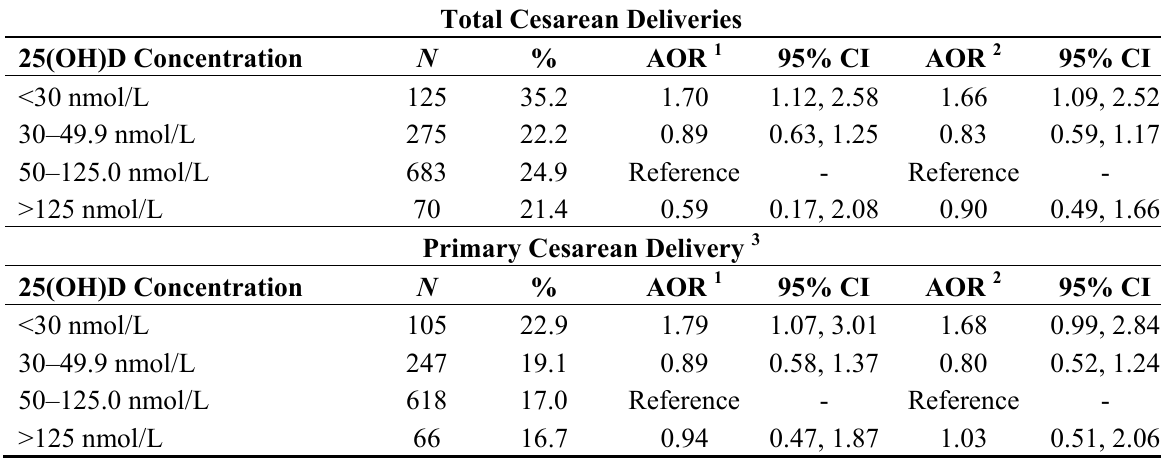
Table 3. Maternal 25(OH) D and Cesarean Delivery (primary,